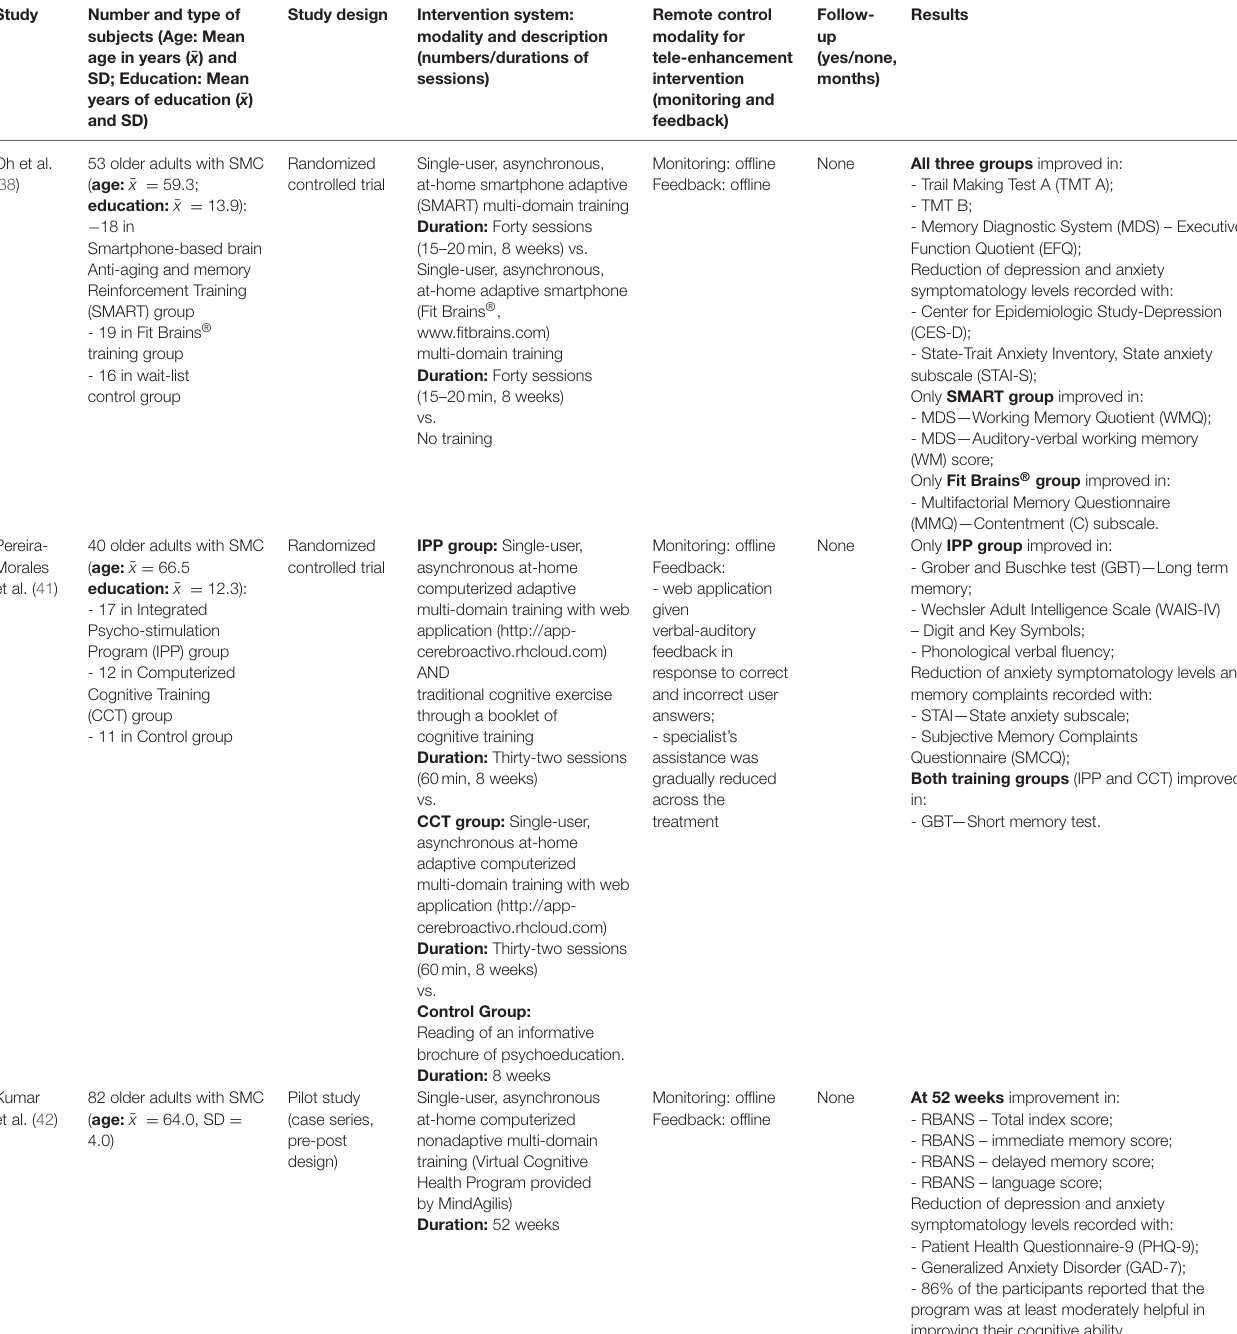
TABLE 2 | Studies that assessed the effects of tele-enhancement cognitive interventions on cognitive functions in subjects with subjective memory complaints.